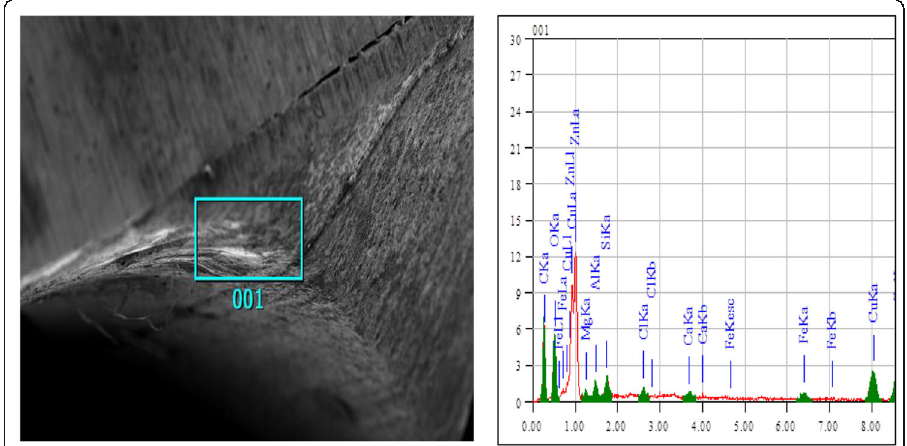
Fig. 11 SEM images of tool B under dry conditions and EDS